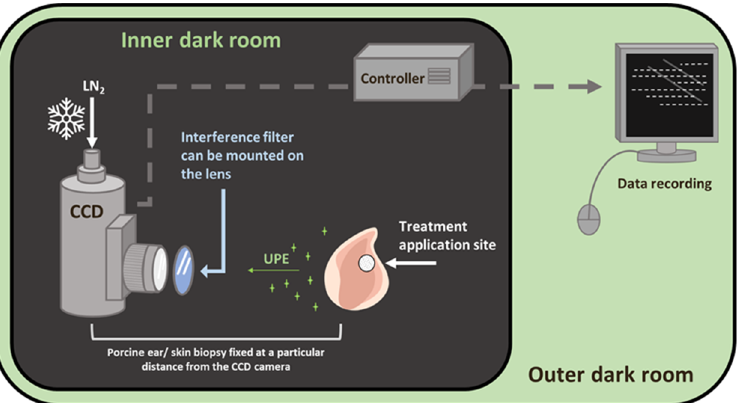
Figure 9. Schematic diagram of the experimental setup for two-dimensional photon emission imaging using a CCD camera. The diagram shows the inner dark room (gray) and the outer control room (green). The filter position for the spectral measurement was positioned in front of the objective lens, as shown.